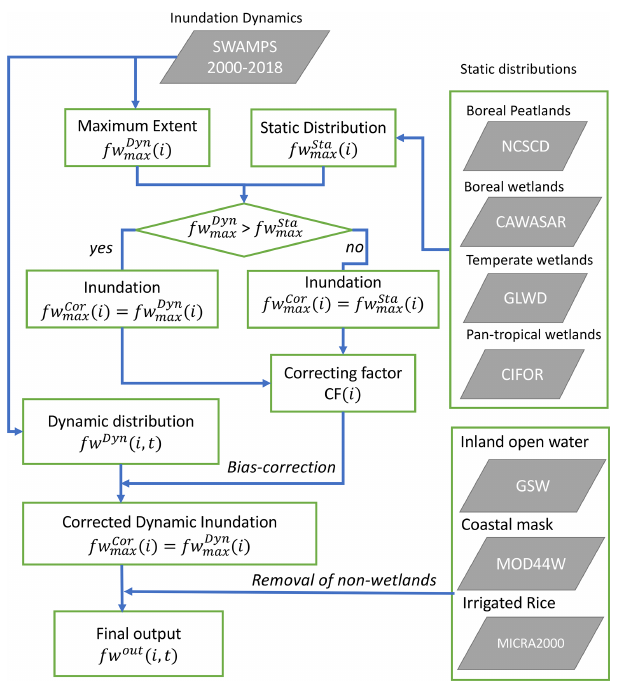
Figure 1. Flow chart of the method describing the wetland extent estimate from SWAMPS and other water body datasets to consoli- date our WAD2M product. The chart describes the step calculating fw in each 0.25 ◦ grid cell i at time (monthly) t